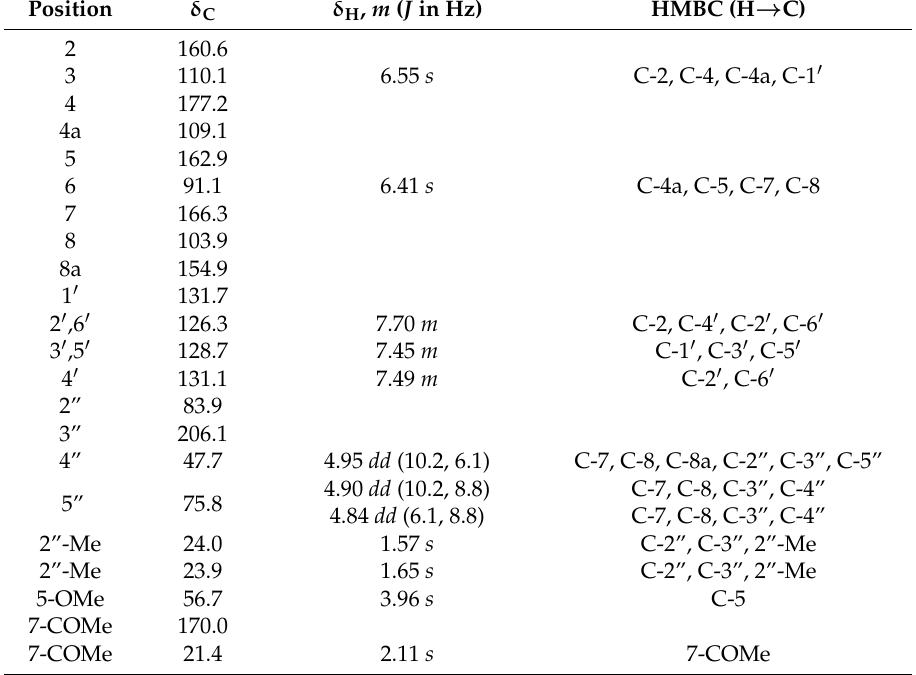
Table 2. 1 H- (800 MHz) and 13 C- (200 MHz) spectroscopic data for compound 4 (CDCl 3 ) at 25 ◦ C. Position δ